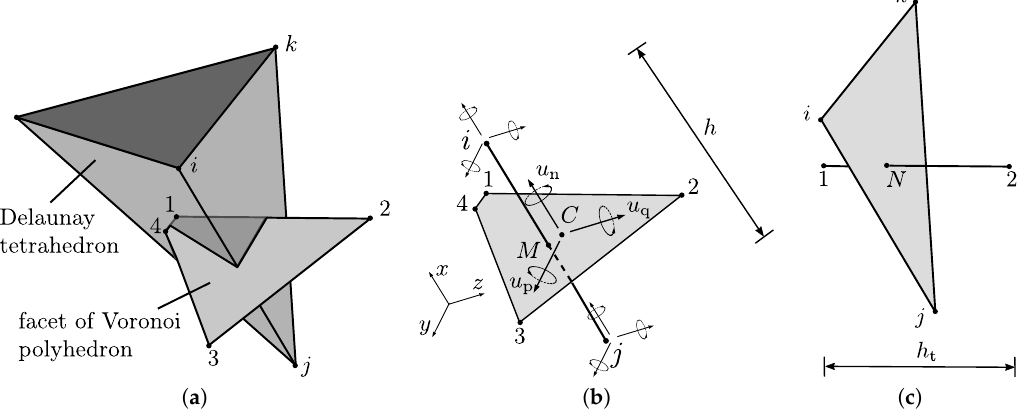
Figure 2. Spatial arrangement of structural and transport elements of the 3D transport-structural network approach: ( a ) geometrical relationship between Delaunay and Voronoi tessellations; ( b ) structural element with cross-section defined by the associated Voronoi facet; and ( c ) transport element with cross-section defined by the associated Delaunay